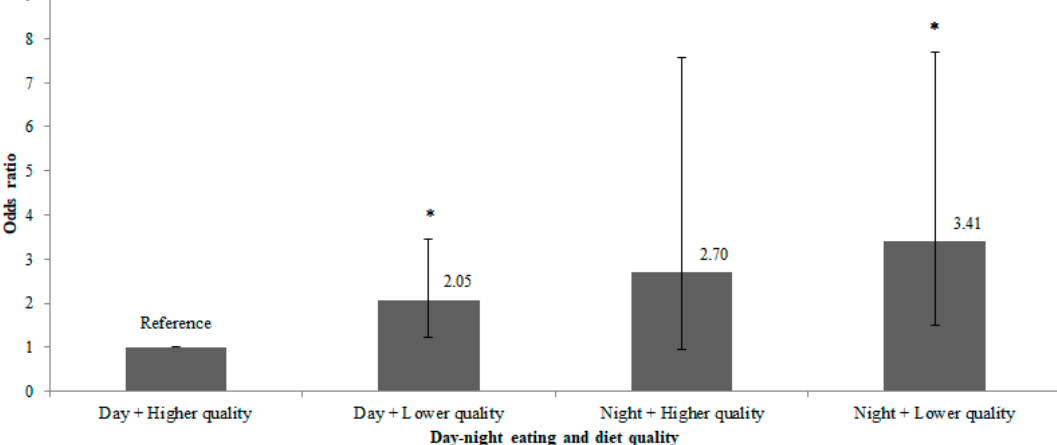
Figure 2. Bar chart presenting the additive effects of day–night eating and diet quality; OR presented are relative to eating pattern of day eating and higher diet quality, OR 1.00). Error bars represent 95% confidence intervals of OR. * p < 0.05. Data were analyzed using the multivariable binary logistic regression model, adjusting for maternal age, ethnicity, education, parity, night shift, total Edinburgh Postnatal Depression Scale score, total energy intake, body mass index at ≤ 14 weeks’ gestation, night fasting intervals, and eating episodes per day. Table 3. Maternal eating patterns during pregnancy and substantial postpartum weight retention ( ≥ 5 kg) at 18 months ( n = 687).